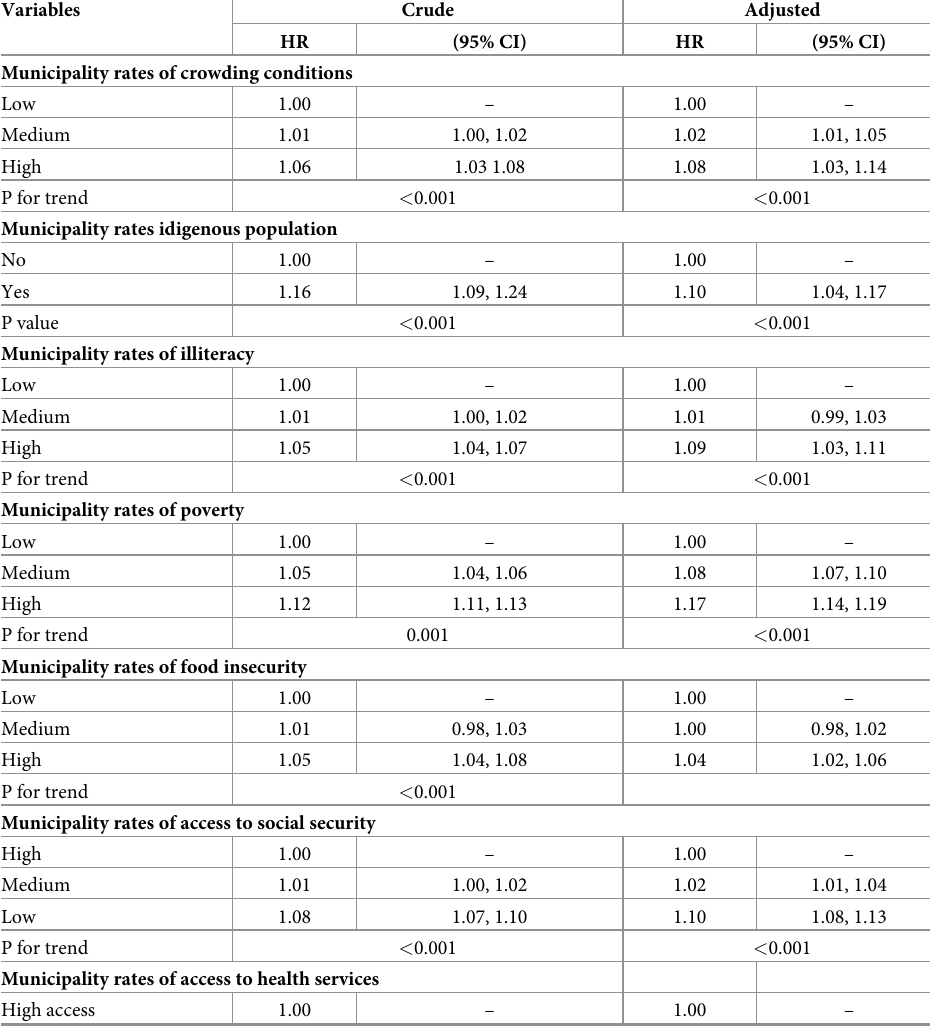
Table 2. Hazard ratios (95% confidence intervals) for mortality amongst those tested positive for